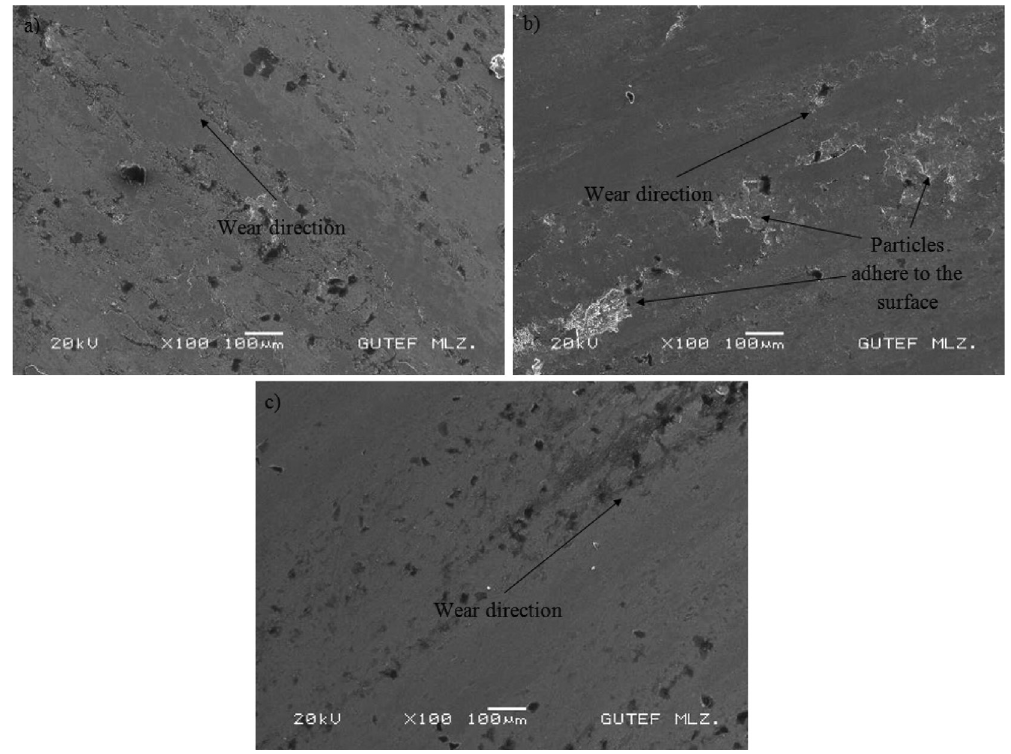
Fig. 8: SEM image of worn surface (a) 10% Cr, (b) 12% Cr and (c) 14%